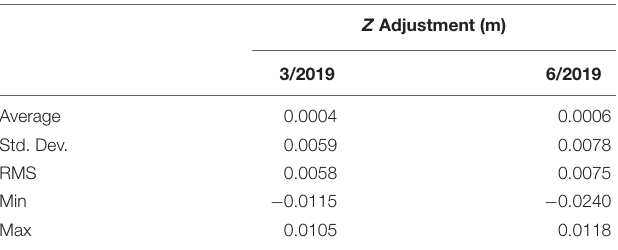
TABLE 1 | Flight elevation ( Z ) adjustment statistics following the direct georeferencing solution for the March and June 2019 survey. Z Adjustment